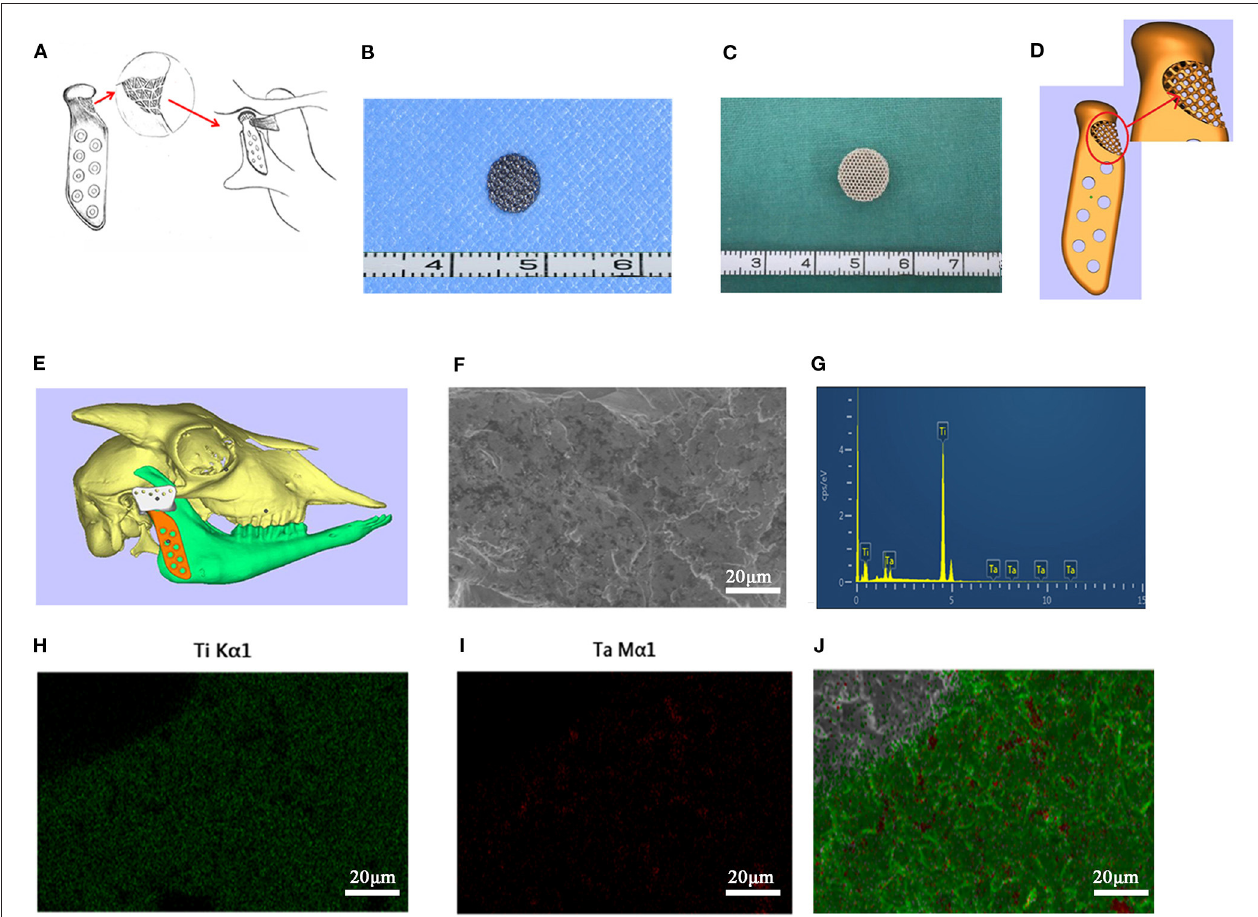
FIGURE 1 | The 3D printed titanium porous scaffold and the elements analysis. (A) The schematic diagram of “LPM functional reattachment region” of TMJ prosthesis. (B) The 3D printed titanium scaffold for cytological experiments. (C) The 3D printed titanium scaffold for rat intervertebral implantation. (D) The CAD design of the novel prosthesis. (E) Simulated surgery and implantation of prosthesis in goat with CAD. (F) SEM scanning of cytological used Titanium scaffold. (G) EDS test of the elements in the 3D printed scaffolds. (H,I) Mapping analysis of the elements in the 3D printed scaffolds. (J) Merge of the EDS mapping analysis.